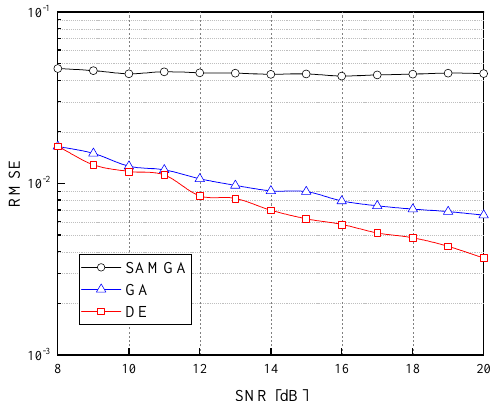
Figure 2. Performances of three estimators on the improved model with CFO values varying in polynomial